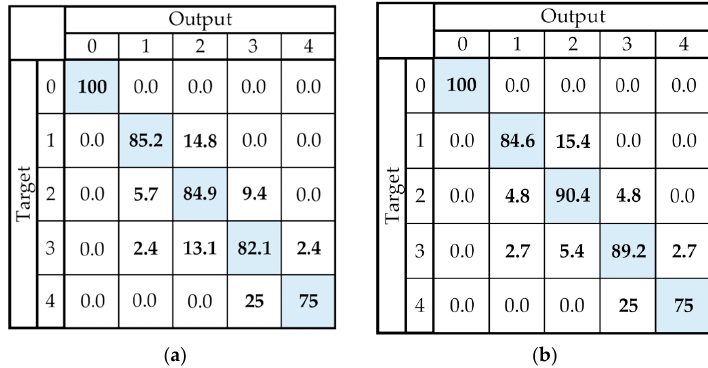
Figure 9. Presentation of results using the confusion matrix. ( a ) Case I—The result obtained when all recordings are included. ( b ) Case II—The result obtained using only recordings on which both raters agreed. The cells on the diagonal of the confusion matrix show the overall success rate for each score (expressed as a percentage (%)), whereas the cells outside the diagonal show the error rate for the scores (expressed as a percentage (%)).